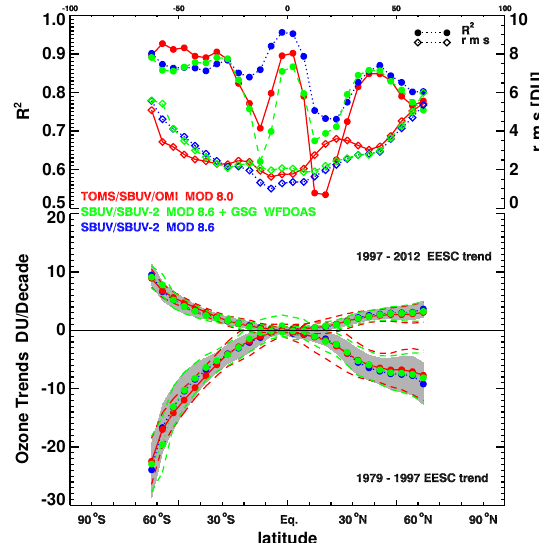
Figure 7. (top panel) Zonal distribution of R 2 and rms estimated for the merged GSG data (July 1995–December 2012) combined with SBUV/SBUV-2 MOD V8.6 data (January 1979–June 1995) displayed in green, SBUV/SBUV-2 MOD V8.6 ozone data (1979– 2012) in blue and TOMS/SBUV/OMI MOD V8.0 merged data (1979–2012) in red. The results refer to analysis based on re- gression Eq. (1). (bottom panel) The EESC-based trends repre- senting the decline from 1979 till 1997 (negative values) and and increase after 1997 (positive values) are displayed for all ozone data sets. Grey shades indicate the statistical significance at two sigma level for SBUV/SBUV-2 MOD V8.6, red dashed lines for TOMS/SBUV/OMI MOD V8.0 and green dashed lines for the SBUV/SBUV-2 MOD V8.6 + GSG WFDOAS data